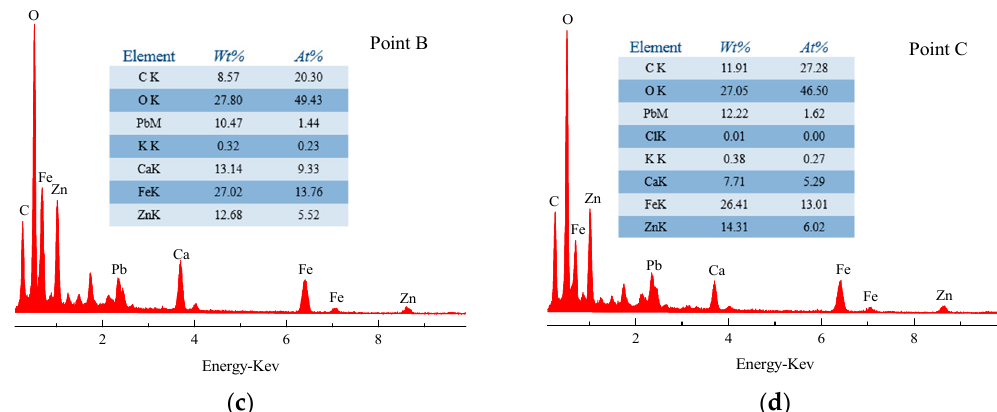
Figure 17. ( a ) SEM pattern of the leached residue; ( b ) EDS pattern of point A; ( c ) EDS pattern of point B; ( d ) EDS pattern of point C.